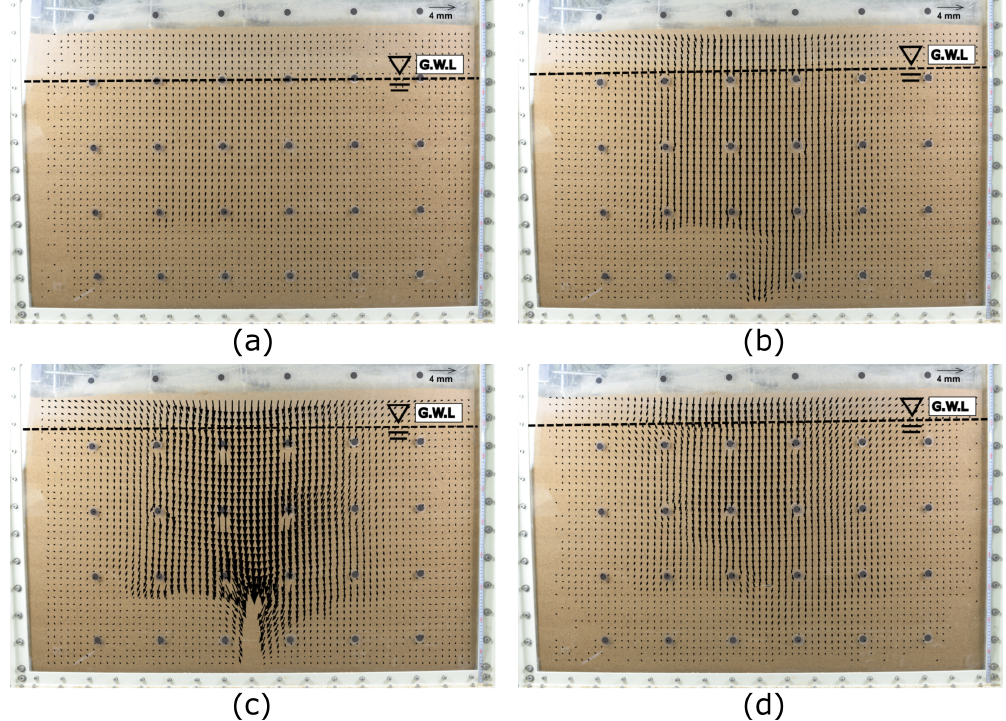
Figure 11. Displacement increment vectors inside the model ground for Test 3 during the water supply stage: (a) 2000–2400s, (b) 2400– 2800s, (c) 2800–3200s, and (d) 3200–3600s.